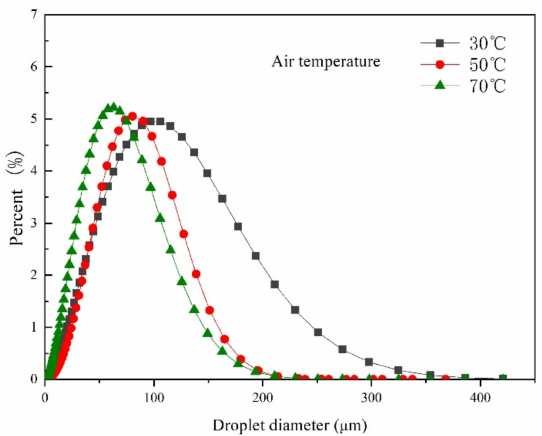
Figure 10. The droplet diameter distribution with different air